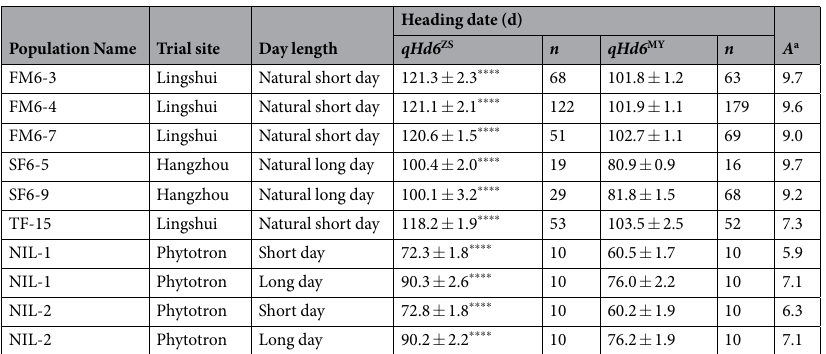
Table 1. Heading date of two homozygous genotypes differing in the qHd6 region. qHd6 ZS and qHd6 MY are near isogenic lines carrying homozygous qHd6 alleles from ZS97 and MY46, respectively. The heading date is presented as mean ± sd . n , number of plants. **** The difference between qHd6 ZS and qHd6 MY is significant at P < 0.0001 using Student’s t -test. a A , additive effect of replacing a MY46 allele with a ZS97